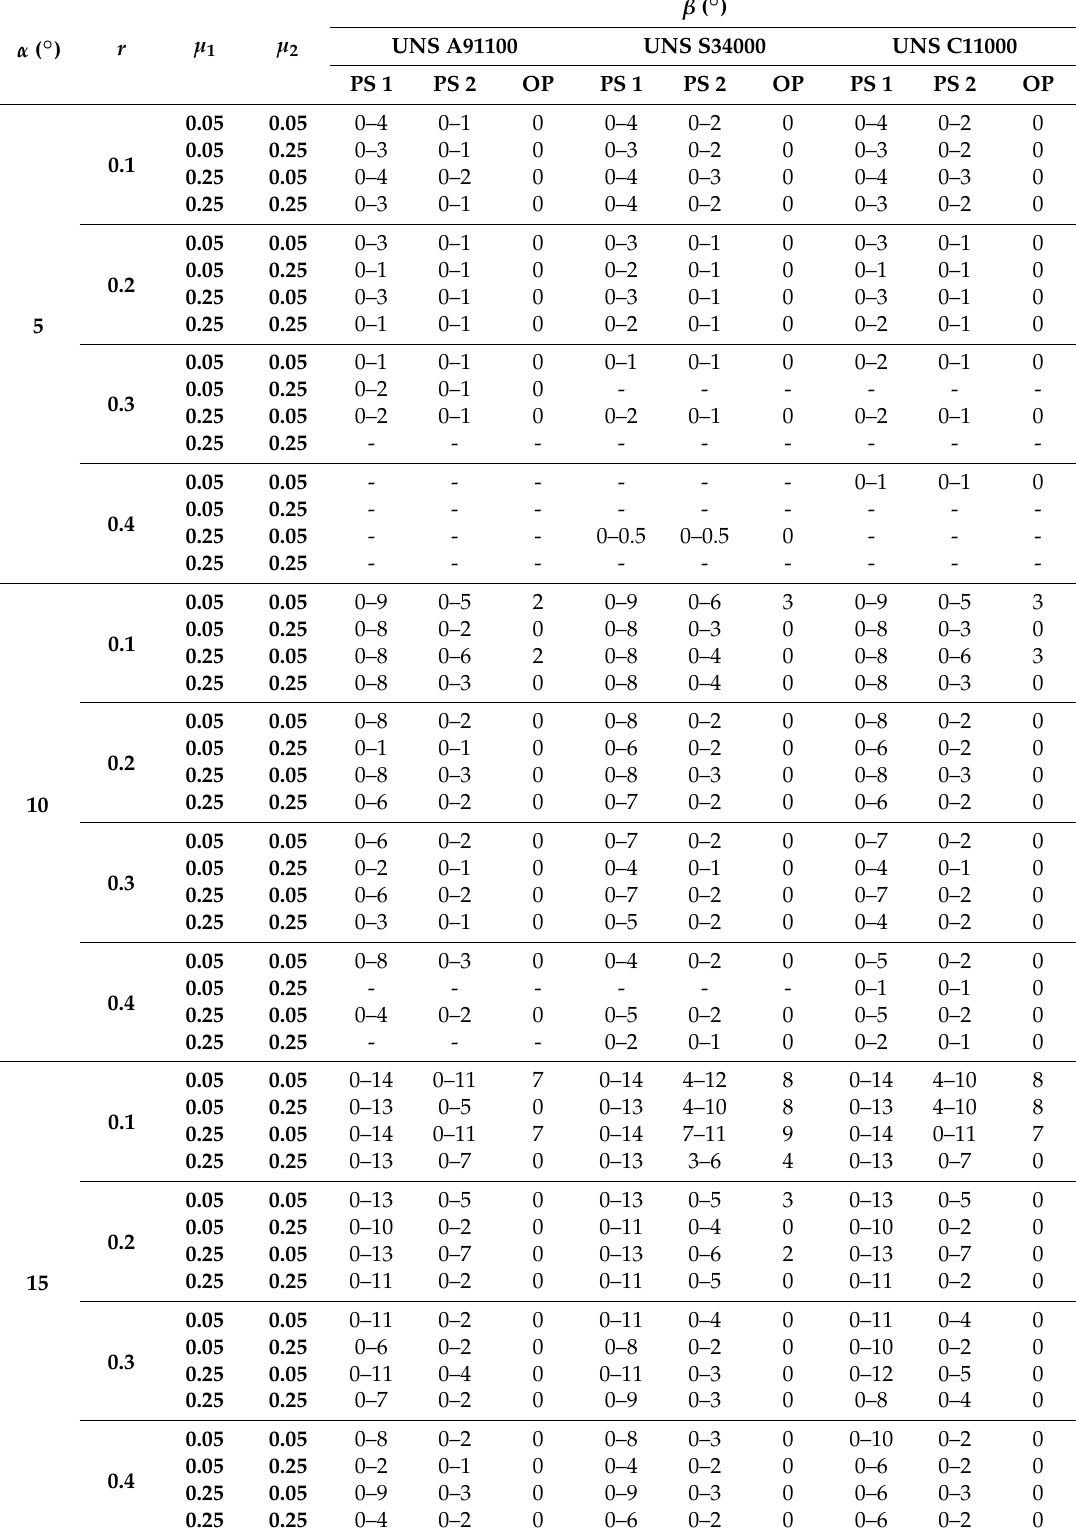
Table 4. PS 1: plugs set that allow carrying out the process; PS 2: plugs set that allow carrying out the process under good conditions in terms of energy consumption; and OP: optimum plug that makes it possible to carry out the process using the minimum amount of